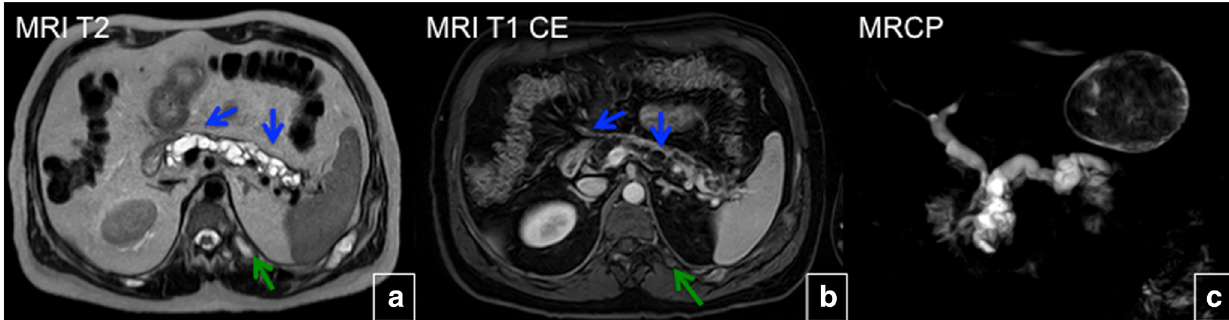
Fig. 28 Intraductal papillary mucinous neoplasms (IPMNs) of the pancreas in McCune-Albright syndrome ( blue arrows ). T2-weighted MRI ( a ), T1 contrast-enhanced MRI ( b ). Coronal maximum intensity